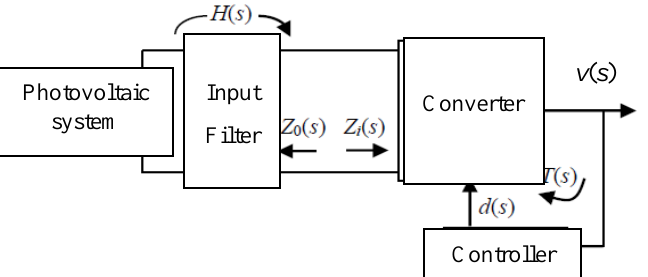
Figure 4. Schematic of the suggested input filter inserted between the PV system and DC (direct current)–DC converter.